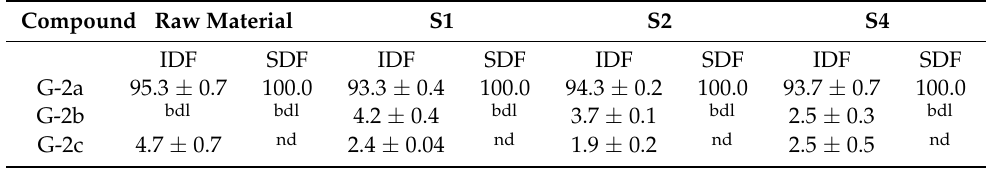
Table A4. Composition (mol%) of galactan oligosaccharides after incubation of insoluble dietary fiber (IDF) and soluble dietary fiber (SDF) of enzymatically treated apple pomace (raw and extruded) with endo-galactanase (mean value ± range/2, n = 2). S1: only transport elements, S2: two reverse elements, S4: two reverse elements and a kneading block, bdl: below detection limit, nd: not detected. Compound Raw